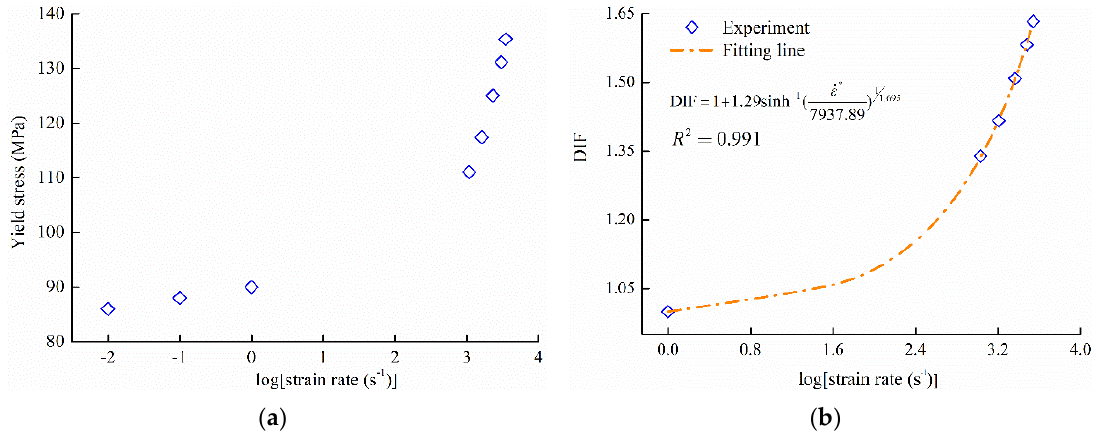
Figure 5. Yield stress of PA66: ( a ) test results; ( b ) fitting results.